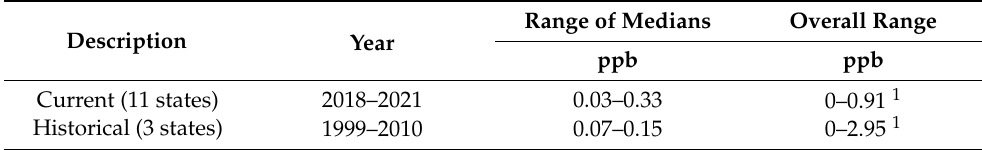
Table 7. Range of medians and overall range of background ambient air EO concentrations associated with various current and historical monitoring programs in the